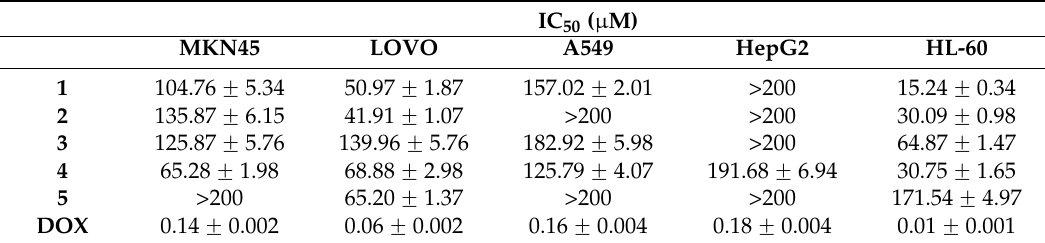
Table 3. Cytotoxic effects of compounds 1 – 5 .